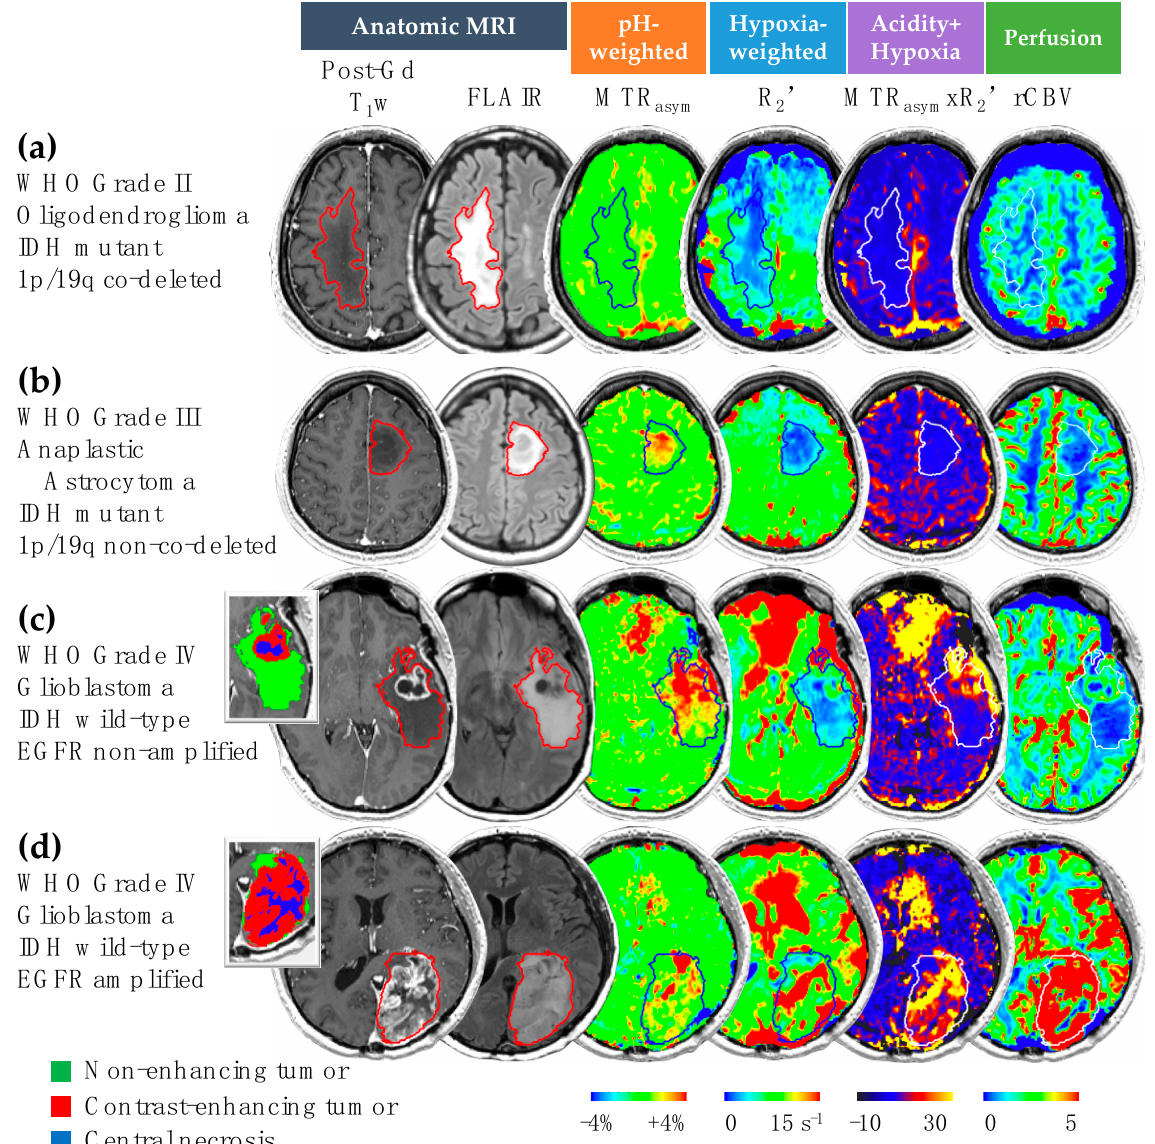
Figure 3. pH- and oxygen-sensitive MR images in representative glioma patients. Four patient examples with IDH mutant 1p/19q co-deleted glioma ( a ), IDH mutant 1p/19q non-co-deleted glioma ( b ), IDH wild-type EGFR non-amplified glioma ( c ), and IDH wild-type EGFR amplified glioma ( d ) are illustrated. Tumors are outlined in each image, with segmented tumor ROIs demonstrated for patients ( c , d ). Regions with elevated acidity, high hypoxia, and increased perfusion in the pH-weighted images, hypoxia-sensitive images, and perfusion images are represented by red colors, corresponding to high values of MTR asym , R 2 ’, and rCBV, respectively. Similarly, a high level of combined acidity and hypoxia is highlighted in yellow on the MTR asym × R 2 ’ map. As demonstrated in Figure 4a–c, tumor region MTR asym at 3.0 ppm, R 2 ’, and MTR asym × R 2 ’ all showed significantly lower values in IDH mutant gliomas compared with IDH wild-type gliomas (MTR asym 1.48 ± 0.45% vs. 1.73 ± 0.50%, p = 1.41 × 10 − 3 ; R 2 ’ 5.17 ± 1.74 s − 1 vs. 5.94 ± 1.54 s − 1 , p = 0.030; MTR asym × R 2 ’ 6.26 ± 3.41 vs. 8.60 ± 3.57, p = 2.57 × 10 − 4 ). These significant differences remained when considering only the treatment-naïve patients